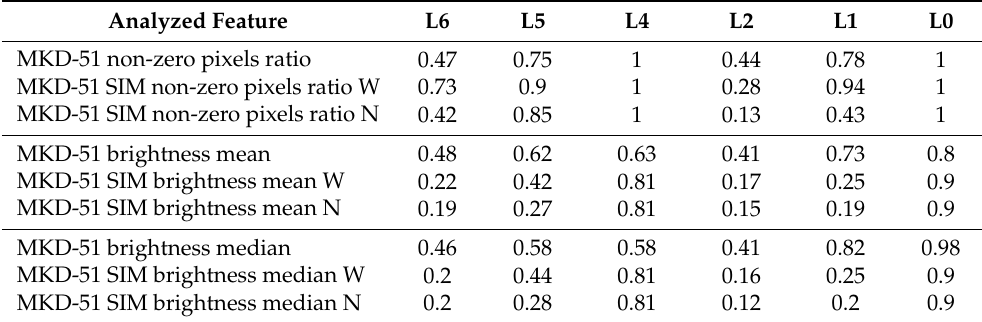
Figure 7. The LED bars driven with different PWMs. ( a , b ) The real MKD-51 photos taken with two different exposures; ( c , d ) MKD-51 SIM with compensation formula; ( e , f ) MKD-51 SIM without compensation formula; ( a , c , e ) LEDs driven with 0%, 30%, 60%, and 100% of PWM duty cycle; ( b , d , f ) LEDs driven with 0%, 10%, 30%, and 100% of PWM duty cycle;. The statistics of normalized images histograms for single LEDs were calculated using perceptual scale. The results are shown in Tables 3 and 4. Table 3. Comparison of LED normalized images statistics with (W) and without (N) brightness compensation for 0%, 10%, 30%, and 100% duty cycle of PWM scheme.